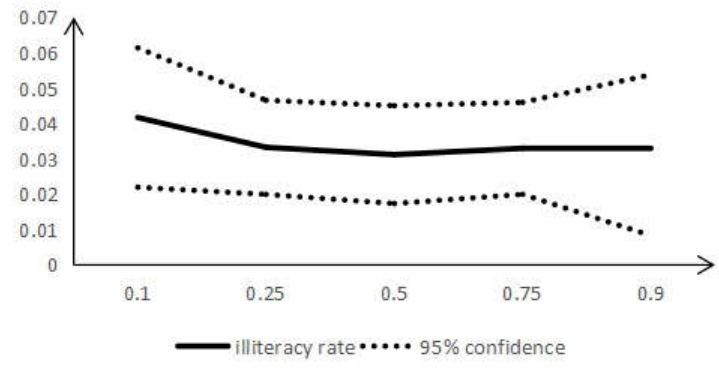
Figure 4. The coefficient of the illiteracy rate under quantile regression.